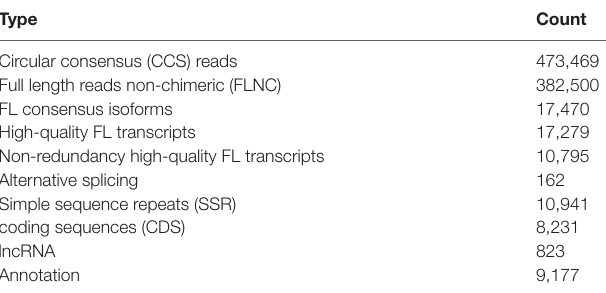
TABlE 1 | Summary of full-length transcriptome sequencing production. Type Count Circular consensus (CCS)